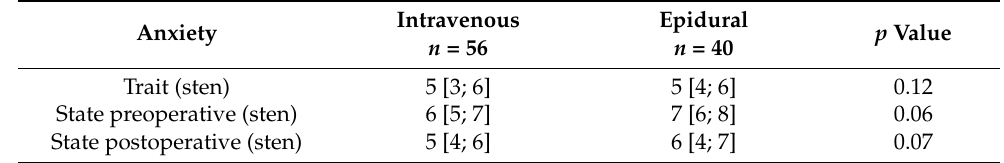
Table 4. Trait and state anxiety in the intravenous and epidural groups.